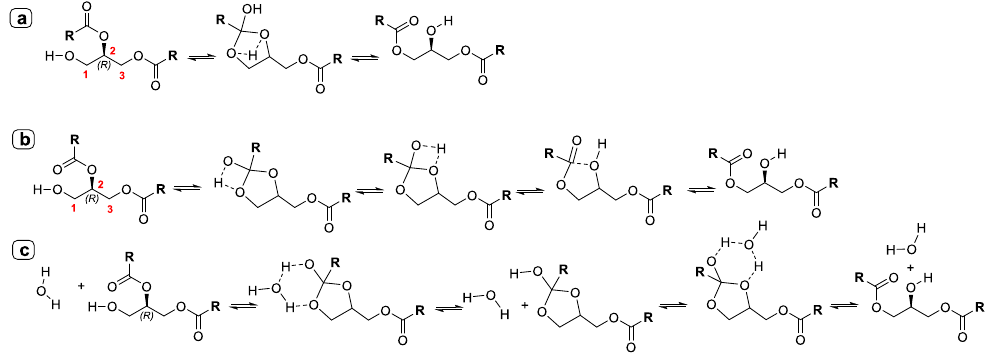
Figure 11. The possible mechanisms of acyl migration in the non-catalyzed mechanism (NCM) scheme: ( a ) concerted pathway; ( b ) stepwise pathway; ( c ) stepwise pathway with the aid of water (adapted from Mao et al. [214]).